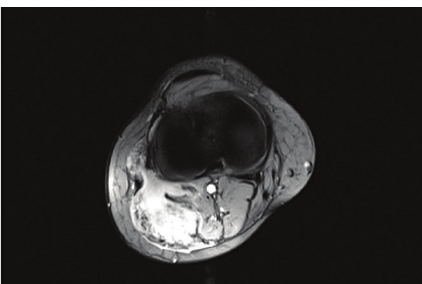
Figure 2: MRI scan, axial view.